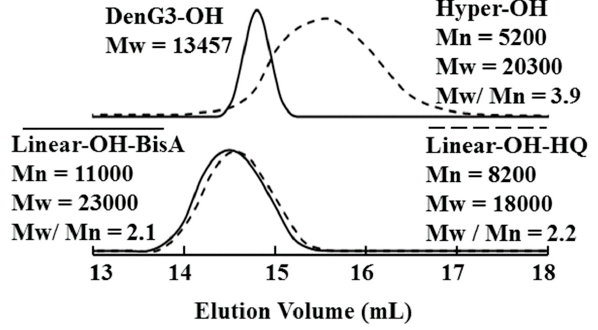
Figure 1. Gel permeation chromatography of DenG3-OH , Hyper-OH , linear-OH-BisA , and linear-OH-HQ .